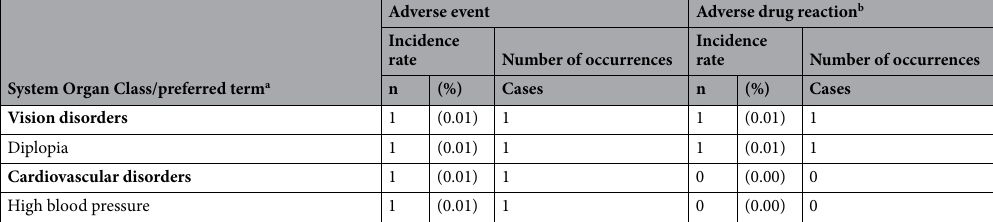
Table 2. The occurrence status of adverse events and adverse drug reactions of aceclofenac CR by System Organ Class. a Some patients had more than one adverse event. b The causal relationship with the use of aceclofenac CR is certain, probable, possible, conditional/unclassified, or unassessable. c Unexpected adverse event.